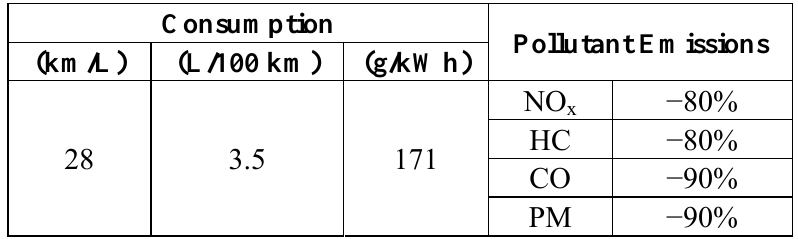
Table 20. Lethe @ data.